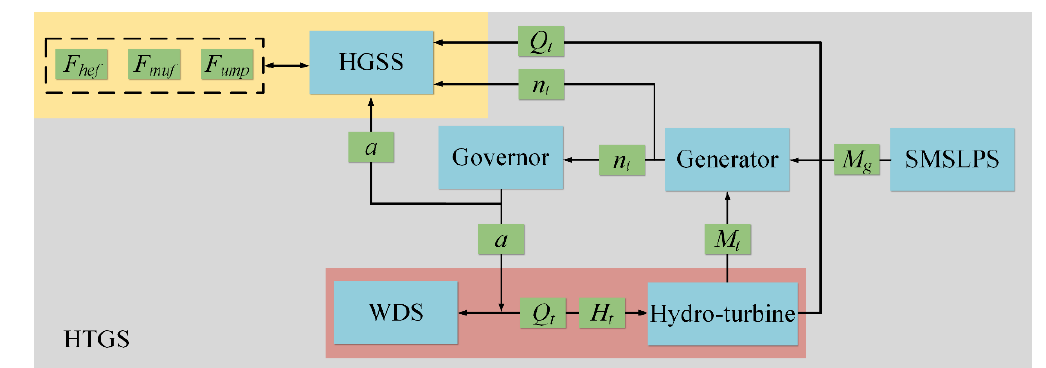
Figure 2. The schematic diagram of the HGS transient nonlinear coupling model.